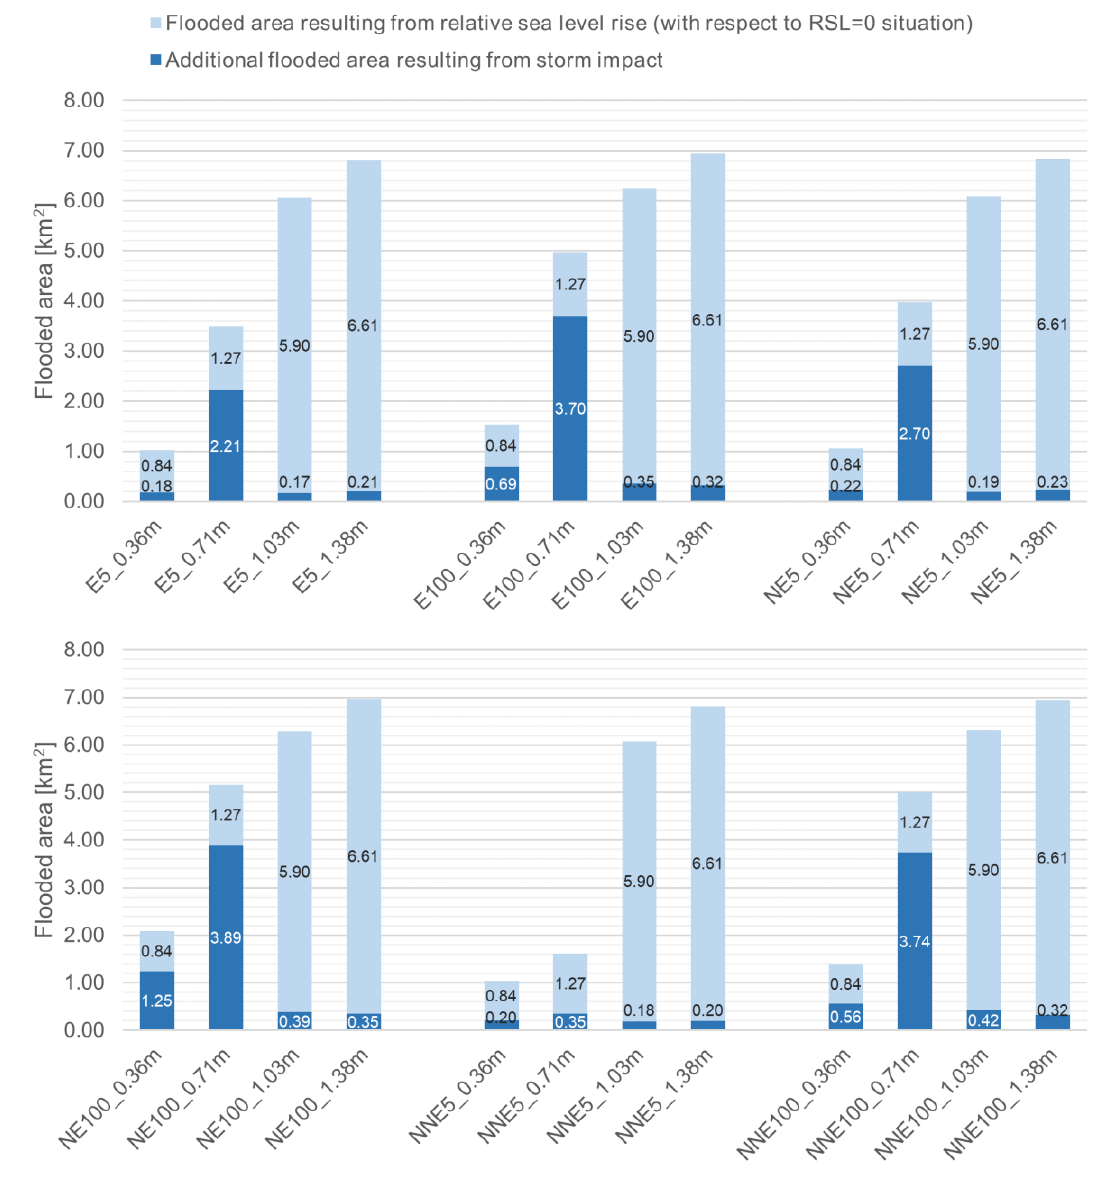
Figure 9. Flooded area compared to that in which no flood situation is associated to future climate scenarios for each of the studied combinations of storm direction, return period and sea level (legend: [storm direction] [return period] _ [sea level]). The total flooded area is divided into the static contribution of relative sea level and the increase of the inundated area due to wave impact and its associated processes (dune erosion, overwash, etc.).